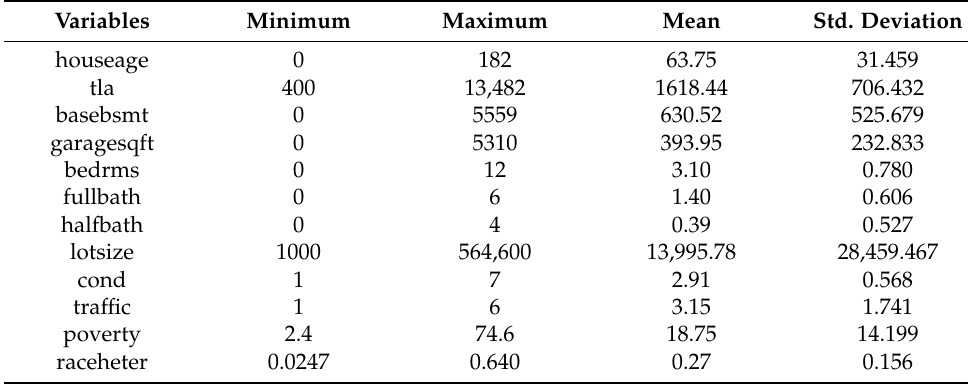
Figure 3. The foreclosure score situation. Table 5. Basic statistics of independent